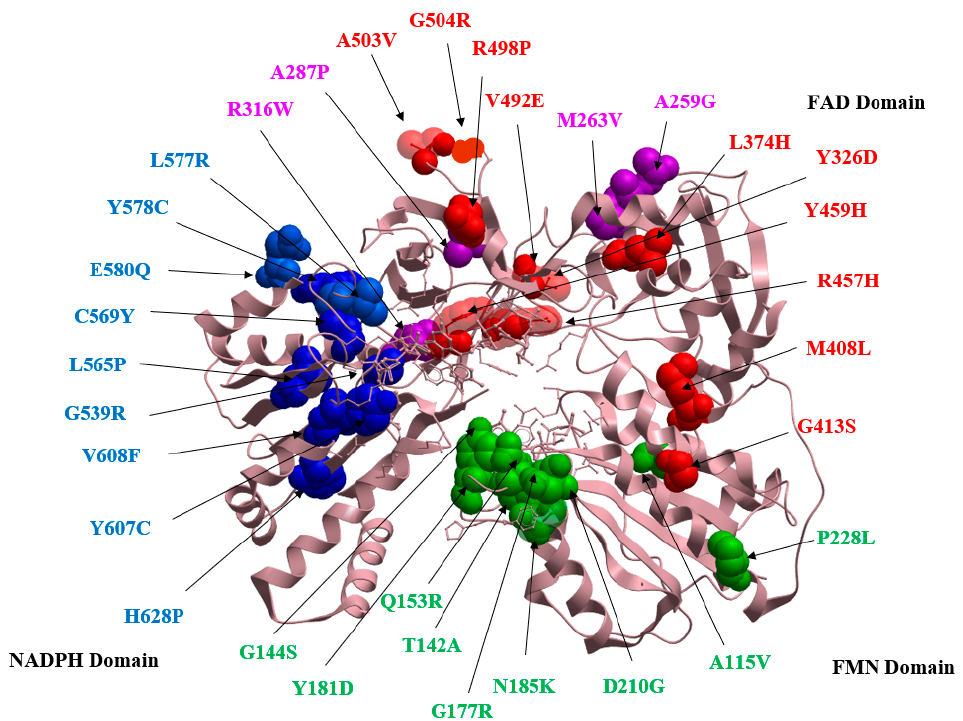
Figure 5. Structure of human POR protein (PDB: 5FA6) represented in a ribbon and balloon model showing the reported missense mutations and polymorphism on their respective binding domains. Green-colored balloons indicate mutations in the FMN domain, red-colored balloons indicate mutations in the FAD domain, and blue-colored balloons indicate mutations in the NADPH domain. Purple-colored balloons indicate mutations found below the FAD-binding domains.